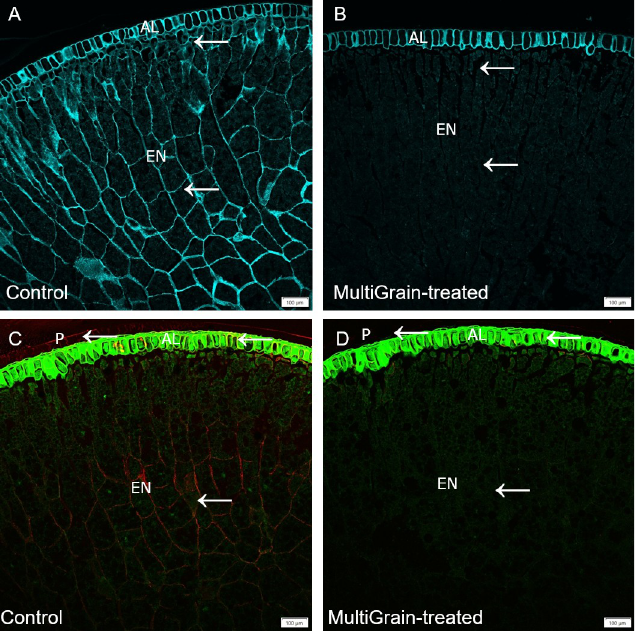
Fig 5. Confocal images of cross sections of whole oat grains. Section of samples incubated (A, C) with sodium acetate buffer (control) or (B, D) with MultiGrain for 3 hours at pH 5. The sections were subsequently (A, B) stained with Calcofluor White, or (C, D) incubated with the antibody detecting (1,3),(1,4)- β -glucan and the red-fluorescence labelled secondary antibody. (A, B) Light blue signal indicates cellulose and other β -1,4-linked glucans. Red signal indicates (C, D) β -glucans and the green signal indicates autofluorescence. AL = aleurone; EN = starchy endosperm. Arrows point to sites where the fluorescence signal due to staining or immunolabelling is present and removed following treatment with MultiGrain. (A, B) Scale bar = 100 μ m. (C, D) Scale bar = 50 μ m.